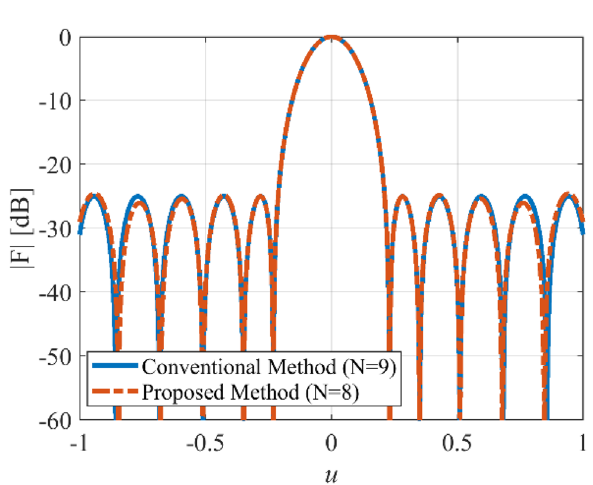
Figure 16. The synthesized results of the fifth case.